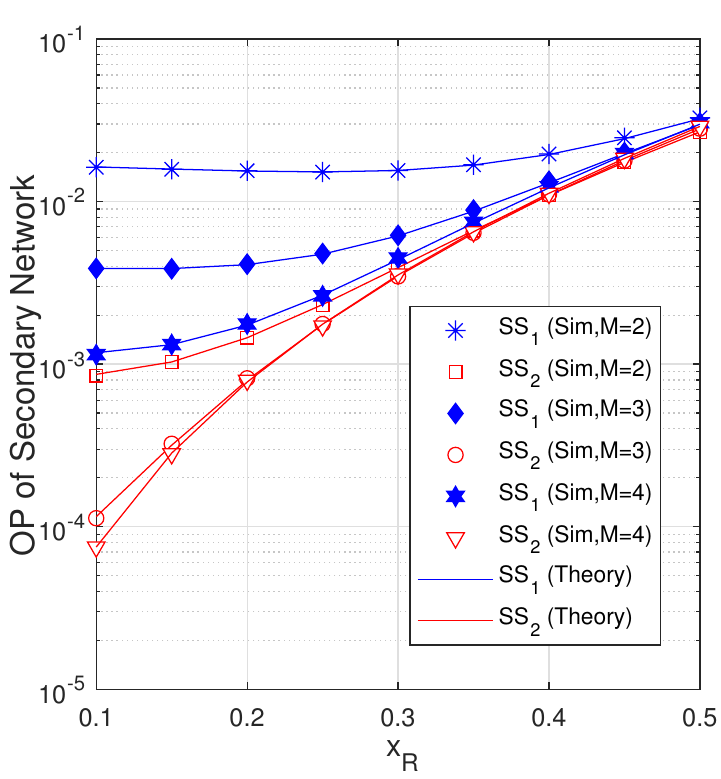
Figure 6. OP of the secondary sources as a function of x R when P PT = 10